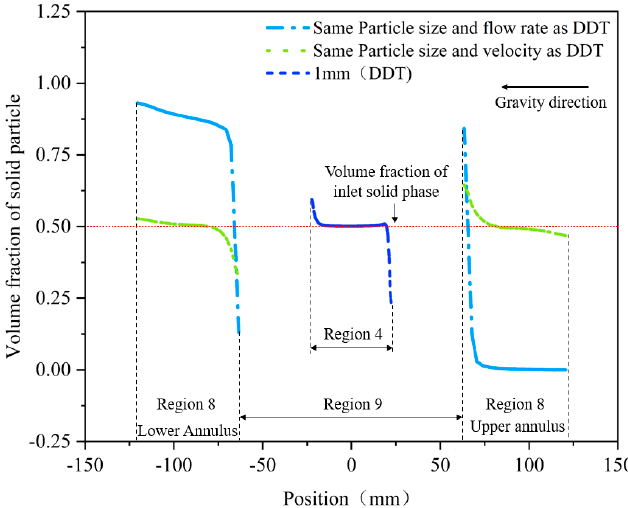
Figure 13. Comparison of migration between the two methods under the same particle size.